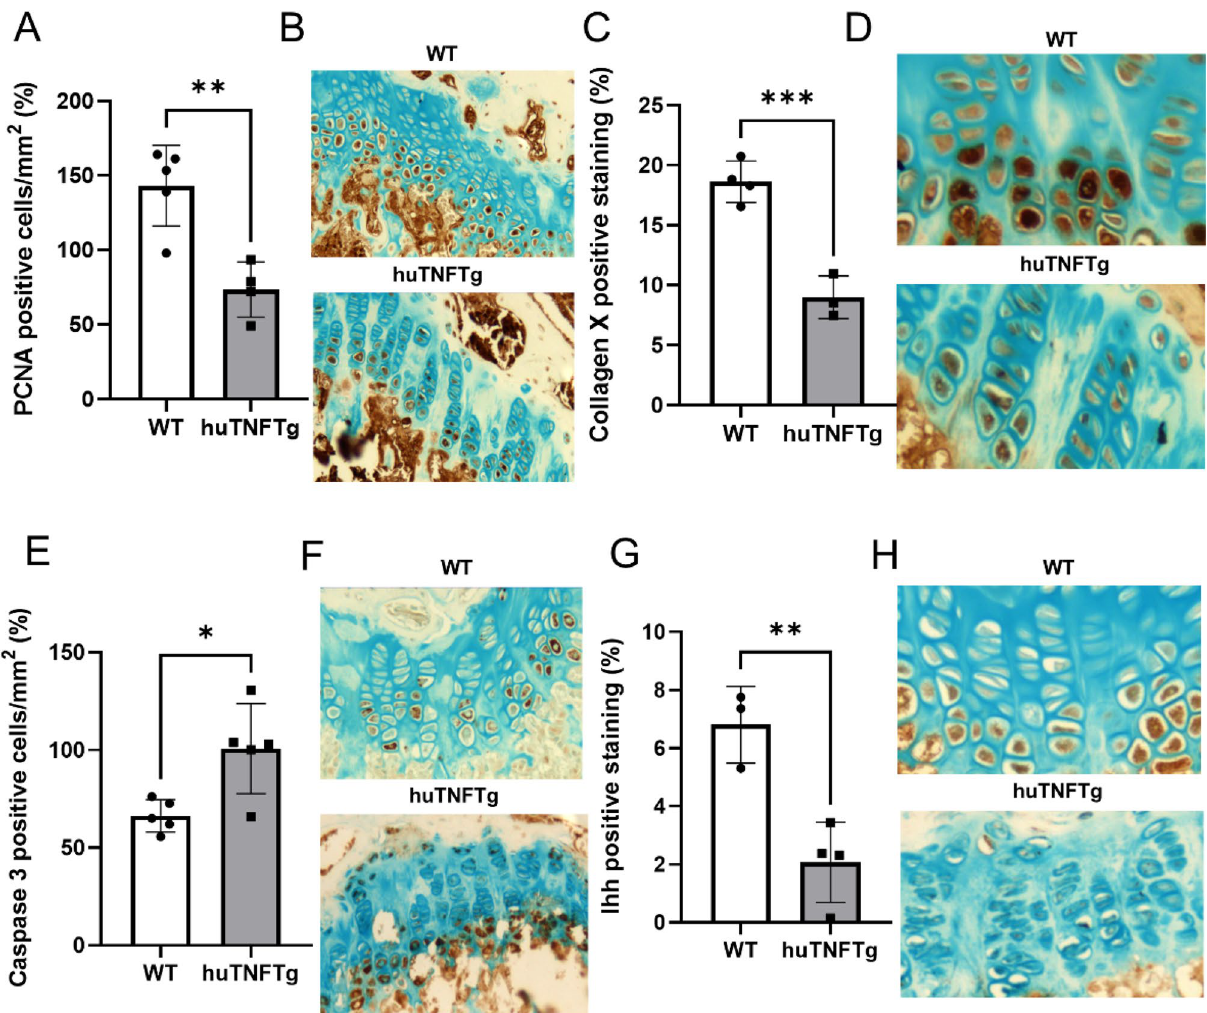
Figure 2. Local effects of human TNF overexpression on chondrocyte proliferation, apoptosis, hypertrophy and Ihh-cxprcssion. Immunohistochemistry analysis performed in femur growth plates of female wild type (WT) and female huTNFTg mice (n = 3–5). ( A, B ) Quantitative analysis of PCNA staining. ( C, D ) Quantitative analysis of collagen type-X staining. ( E, F ) Quantitative analysis of caspase-3 staining. ( G, H ) Quantitative analysis of Ihh staining. PCNA and caspase-3 staining quantified as number of positive cells per mm 2 . Ihh and collagen type-X staining calculated as percent of positively stained area over total growth plate area. Error bars indicate mean ± SD. Students t-test was used to analyze differences between groups. * p < 0.05, ** p < 0.01 *** p <